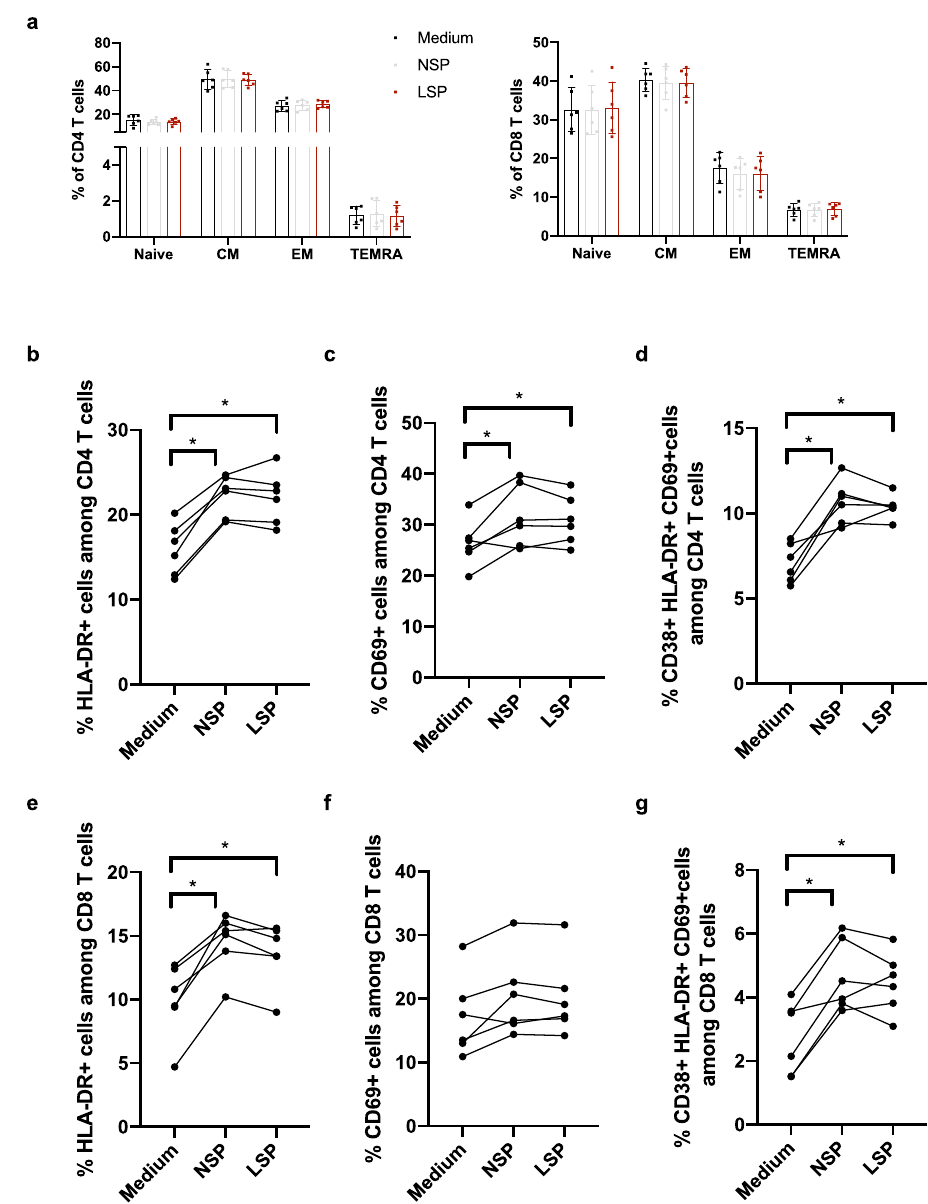
Fig. 5 Phenotype and activation status of leukocyte populations present in the sigmoid colon before and after exposure to seminal plasma. Lamina propria mononuclear cells isolated from six different donors were incubated 2 h with medium, 25% NSP or 25% LSP, washed, and immunophenotyped 72h later. a The graph shows the proportion of naive, central memory (CM), effector memory (EM), and effector memory RA (TEMRA) cells among colonic CD3 + CD4 + and CD3 + CD8 + T cells. Each symbol represents one animal and the mean± SD is shown. b – g Expression of the activation markers HLA-DR ( b , e ), CD69 ( c , f ) and highly activated CD38 + HLA-DR + CD69 + cells ( d , g ) by CD3 + CD4 + ( b – d ) and CD3 + CD8 + T cells ( e – g ) from the colon. Each symbol represents one animal. p < 0.05 denotes signi fi cant difference between conditions (Friedman tests with post hoc Benjamini, Krieger, and Yekutieli